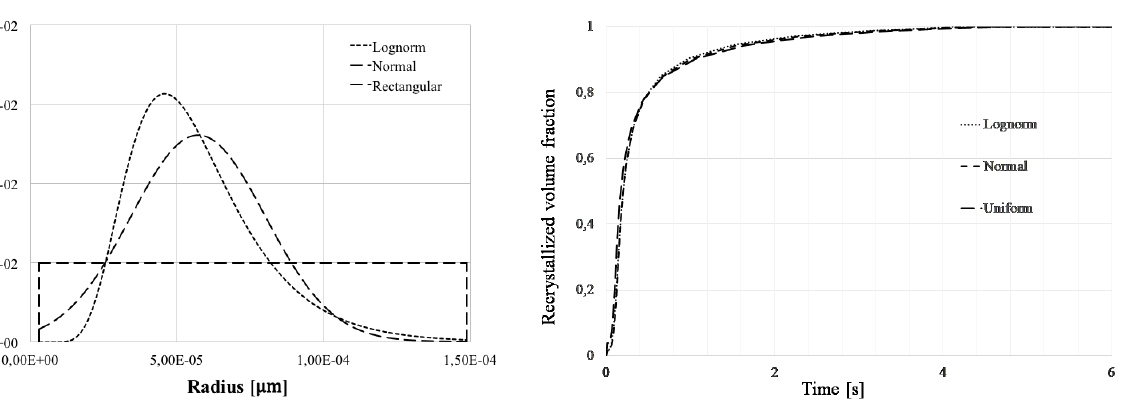
Figure 3: Recrystallized volume fraction, for the first seconds of simulation, for the three different